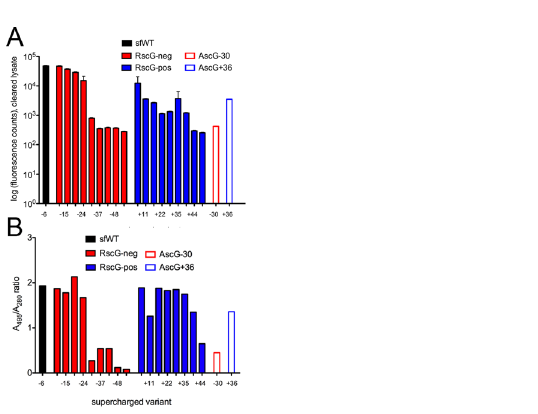
Figure 8. Expression and relative folding of supercharged GFP variants. A) Total fluorescence values indicate the level of expression of correctly folded GFP. The low- to mid-charge negative variants expressed well, but mid- to high-charge variants expressed significantly worse that sfWT. B) Absorbance ratios indicate the relative amount of correctly folded GFP. Absorbance by the chromophore at 495 nm indicates correctly folded GFP, and absorbance at 280 nm indicates the total amount of GFP. Low- to mid-charge variants are well folded (before thermal challenge), while high-charge variants are not well